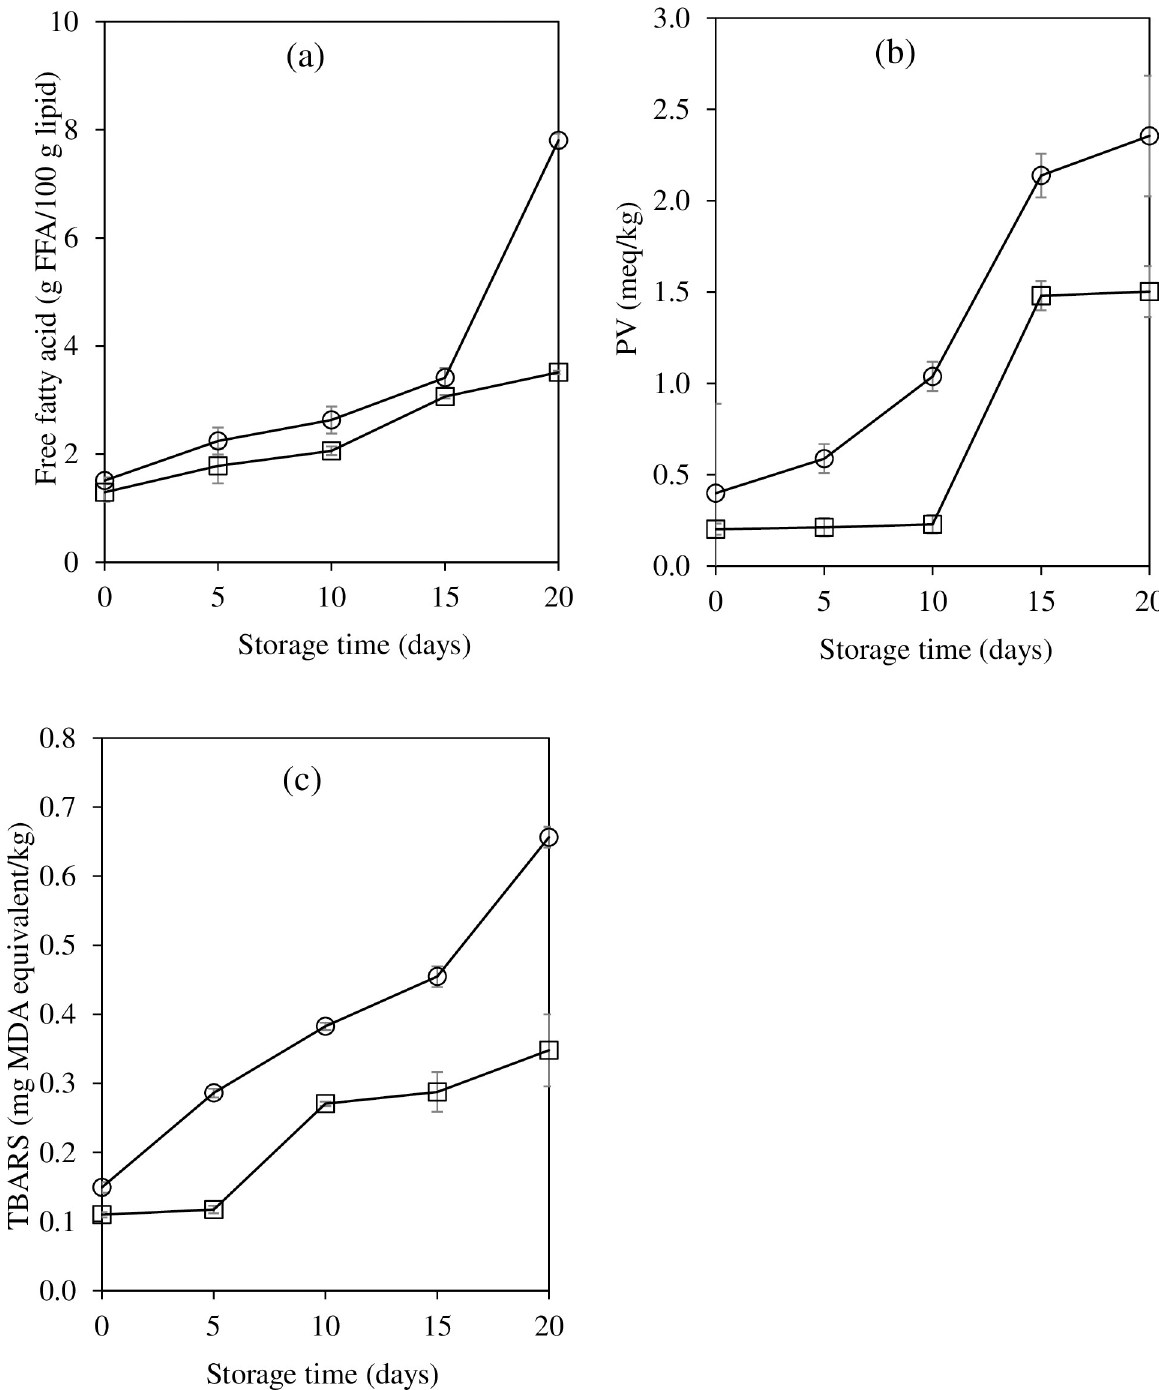
Fig 3. Changes in free fatty acid content (a), peroxide value (PV) (b), and thiobarbituric acid reactive substances (TBARS) content (c) of semi- dried Chinese style tilapia sausages formulated with pork back fat (control; � ) and carrageenan based emulgel ( □ ) during storage at room